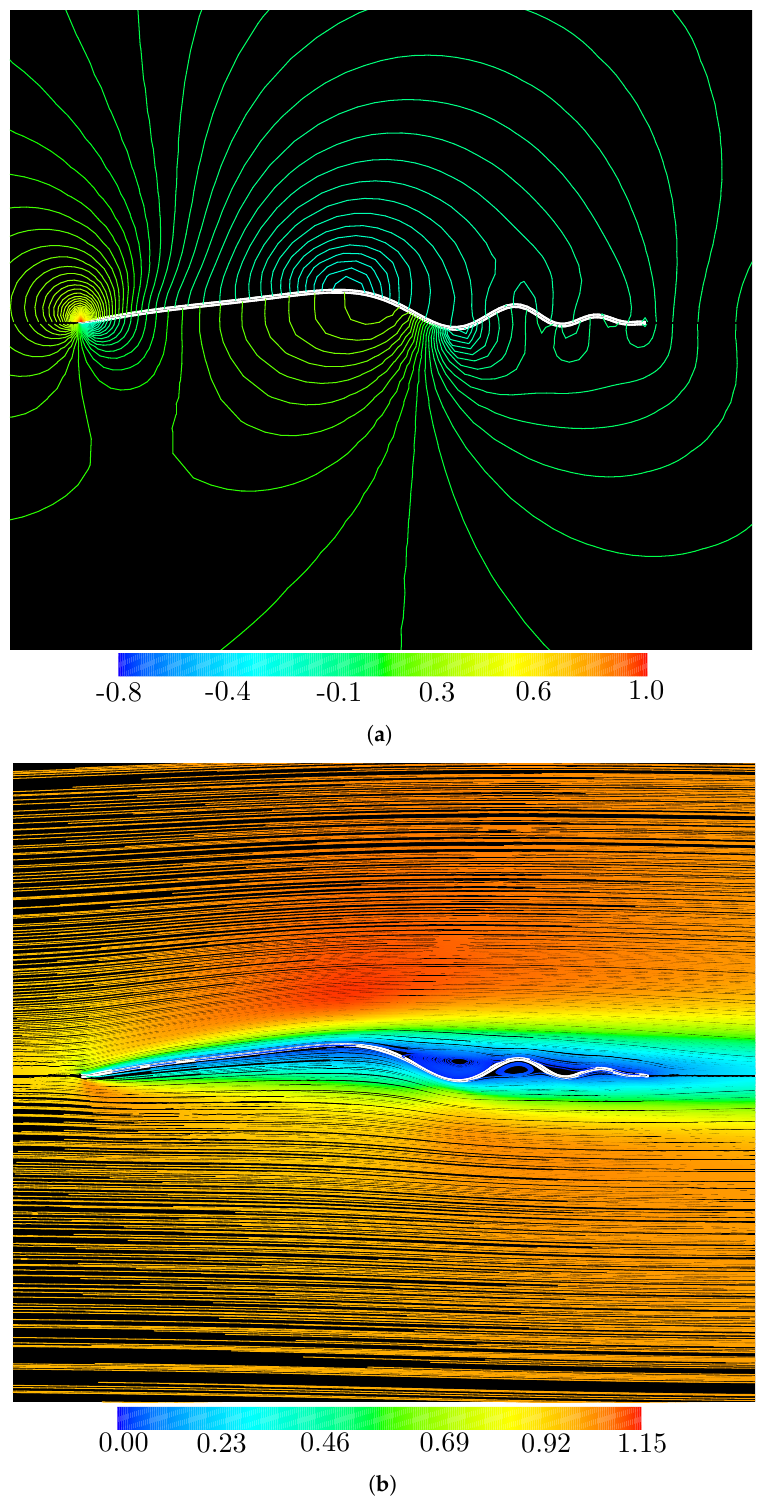
Figure 12. Flow past the shape Wavy _2 (Table 3) at Re = 10 3 and α = 0 ◦ : ( a ) time-averaged pressure isolines; and ( b ) time-averaged